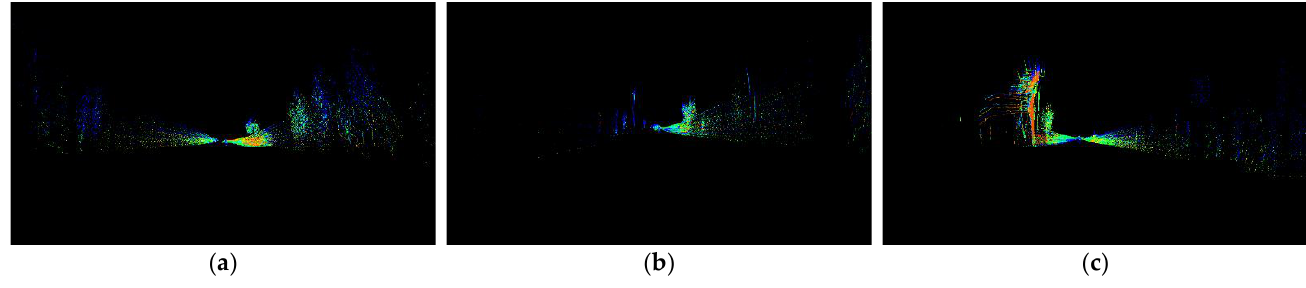
Figure 12. Point cloud image scene 8: Rappahanock ( a ) Picture 1, ( b ) Picture 2, ( c ) Picture 3.